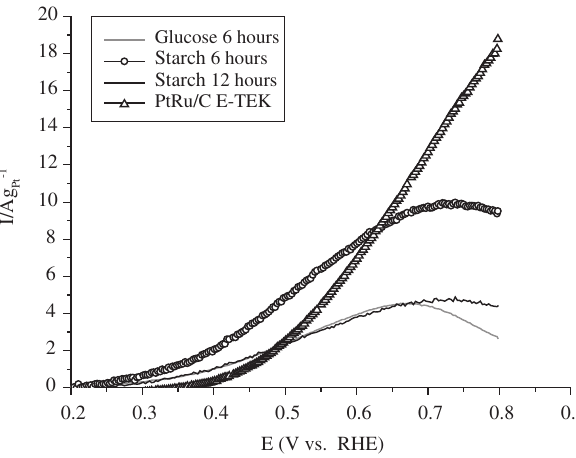
Figure 6. Cyclic voltammograms of PtRu/Carbon materials in 0.5 mol.L -1 H SO containing 1.0 mol.L -1 of methanol with a sweep rate of 10 mV.s -1 , 2 4 considering only the anodic